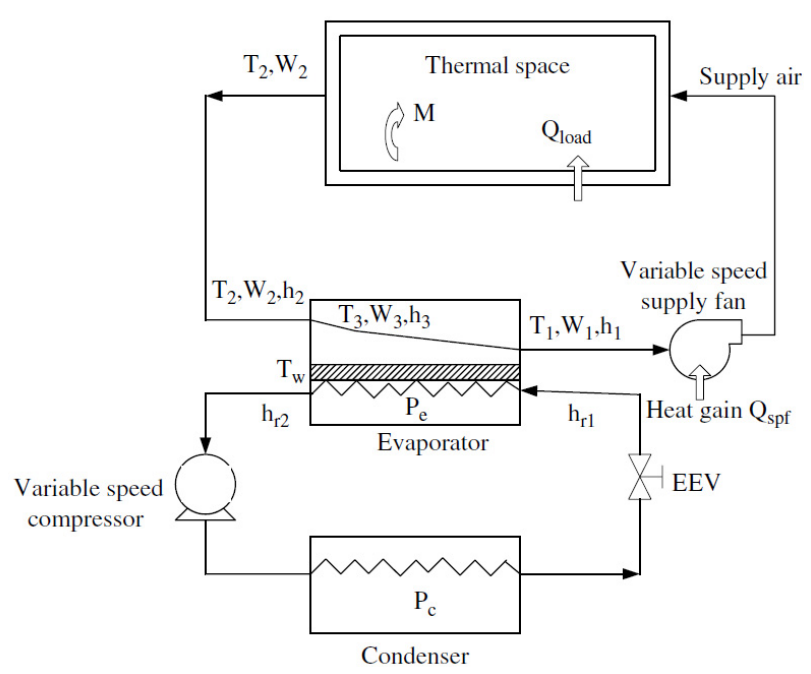
Figure 1. Schematic diagram of the experimental VS DX A/C system.